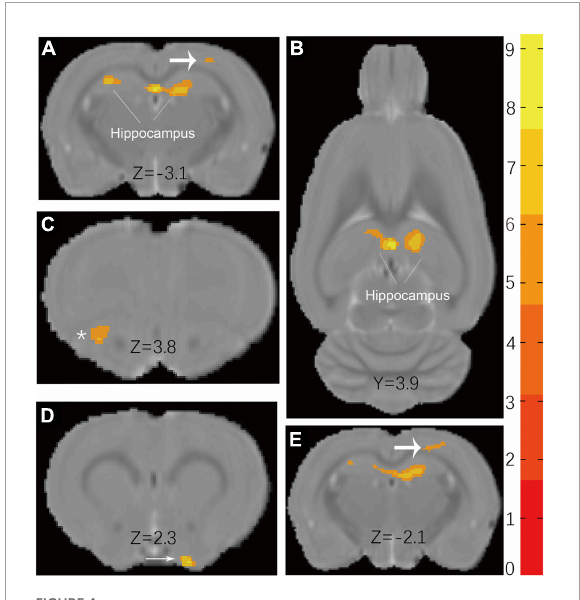
FIGURE4 Results (A,B) of VBM detect atrophy in hippocampus of male CHH rats in coronal slice and axial slice, compared to male control rats. In addition, coarse arrow (A,E) , * (C) , and thin arrow (D) also show a significant atrophic effect in the primary somatosensory cortex, olfactory bulb, and basal forebrain region, respectively. (The male CHH group, n = 8; male control group, n = 8; uncorrected p < 0.0001). Color bar units refer to t